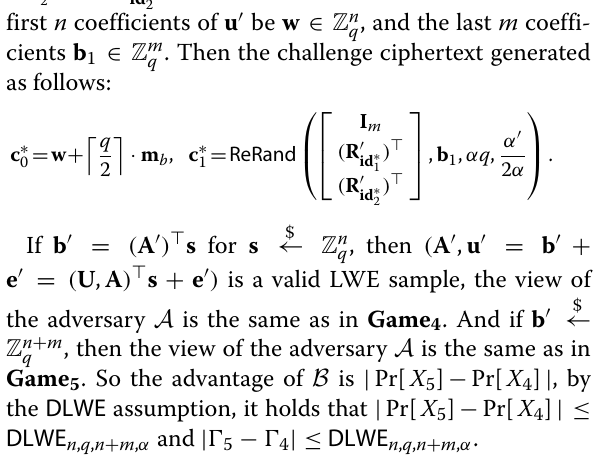
= AR (cid:8) id ∗ 1 1